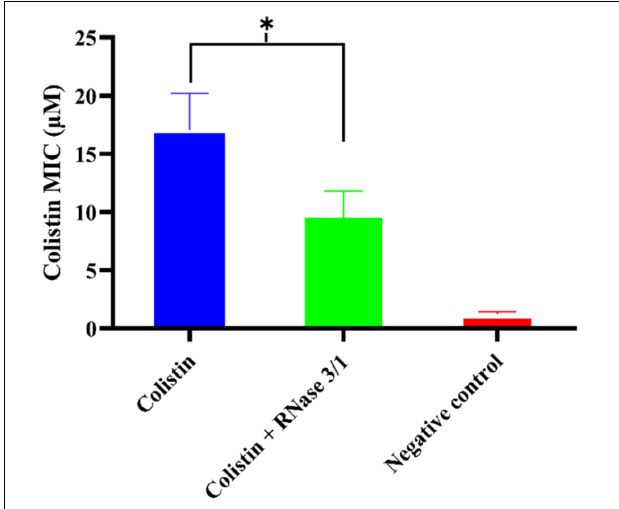
FIGURE 7 | Comparison of the calculated average mean MIC value following Assay 1 treatment for RNase 3/1-supplemented versus non-supplemented bacterial strains exposed to colistin. Error bars show the standard error of the mean. ∗ indicates that the p -value is <